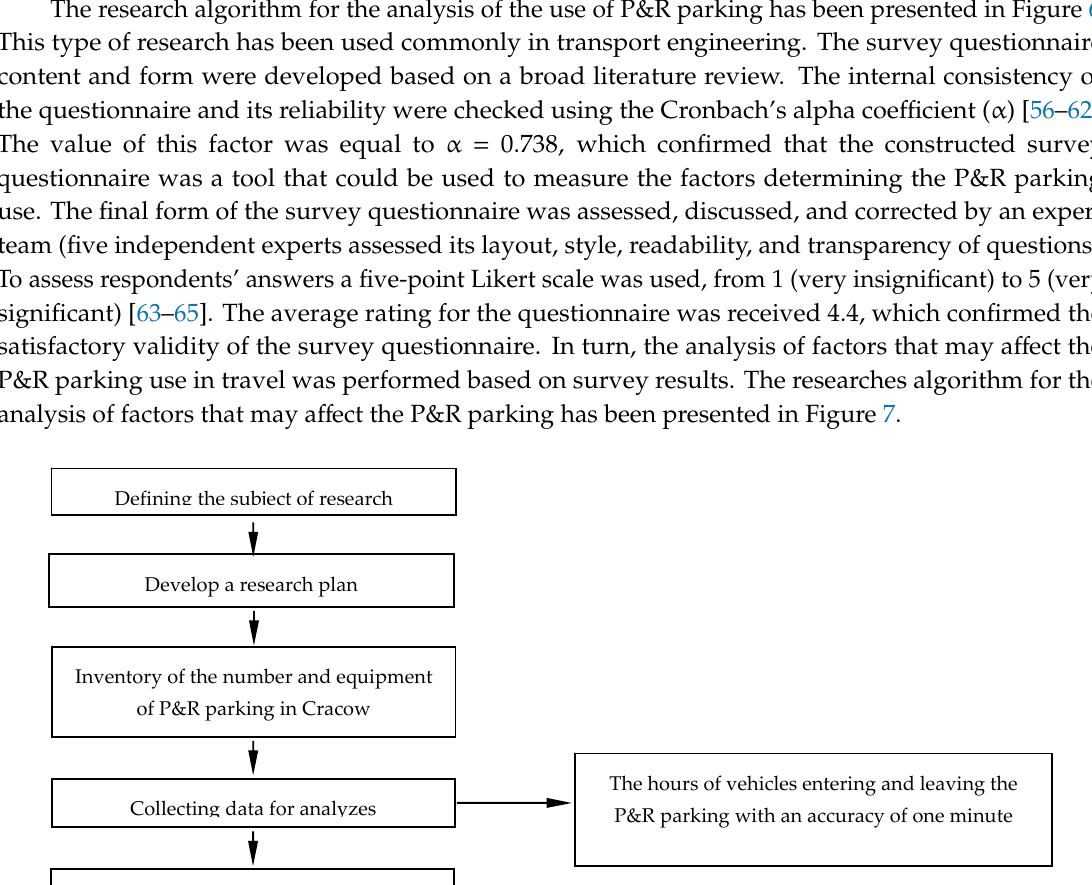
Figure 5. Examples of offered parking spaces in the P&R parking Bie ż anów in Cracow: ( a ) parking